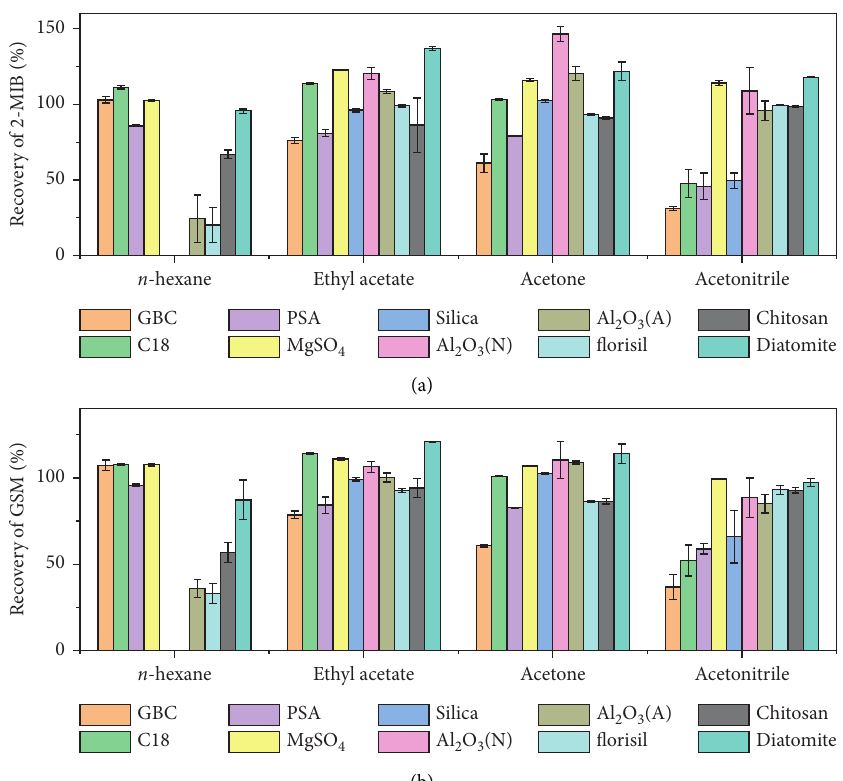
Figure 2: Recoveries of 2-MIB (a) and GSM (b) after adsorption in different solvents with different adsorption materials. Spiked con- centration: 50